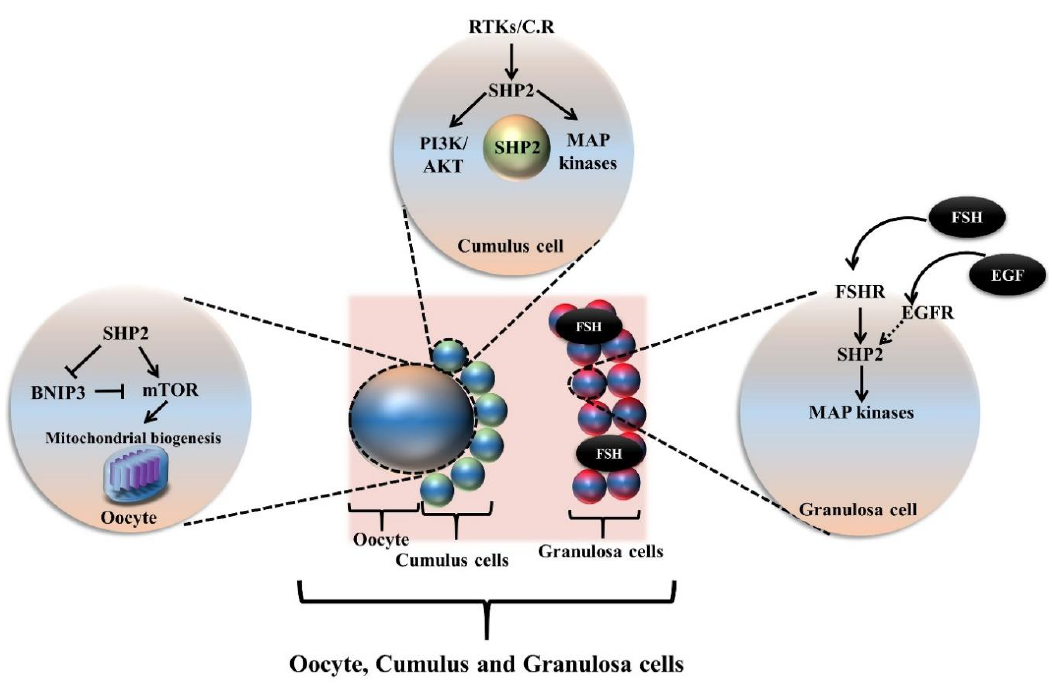
Figure 3. Oocyte maturation and ovulation is a critical process for female fertility. SHP2 is found to be critical for the FSH signaling in granulosa cells and its inhibition significantly reduced MAP kinases. SHP2 also shows expression in cumulus cells, and it has been identified that SHP2 is nuclear localized in the germinal vesicle stage cumulus-oocyte complex. SHP2 expression becomes enhanced by EGF, FGF, and LIF addition to maturation media during oocyte in vitro maturation. Other than that, SHP2 is also involved in negatively regulating the mitophagy, of the oocyte, by enhancing mTOR induced mitochondrial biogenesis and inhibit BNIP3.